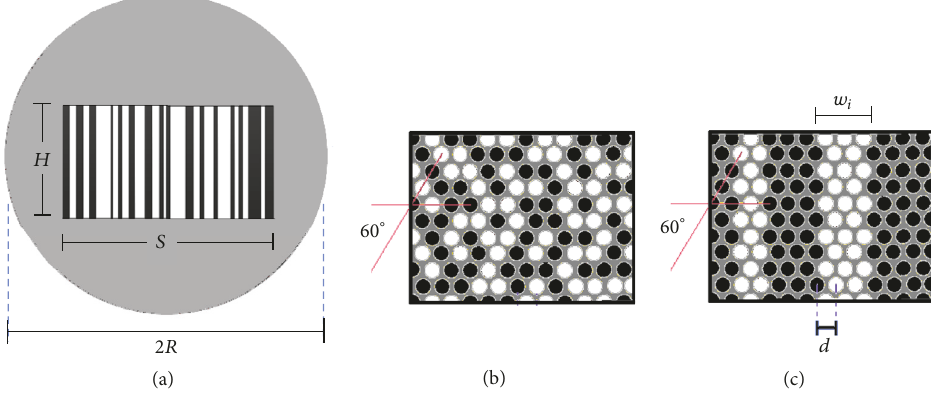
Figure 1: (a) Top view of the schematic representation of the inscription of information on magnetic bar codes inside a circular membrane of radius 𝑅 and height 2𝐿 . Wires are perpendicular to the page penetrating it for the full length 2𝐿 . Black areas represent wire magnetizations pointing up; white areas represent wire magnetization pointing down; gray areas indicate random orientation. An arbitrary bar code is shown in a rectangle of length 𝑆 and height 𝐻 . (b) Magnification of a possible background area presenting no magnetic order with total nil magnetization; (c) magnification of the bar code area showing ideal magnetization profiles producing bars with generic width 𝑤 𝑖 , where 𝑖 runs over all